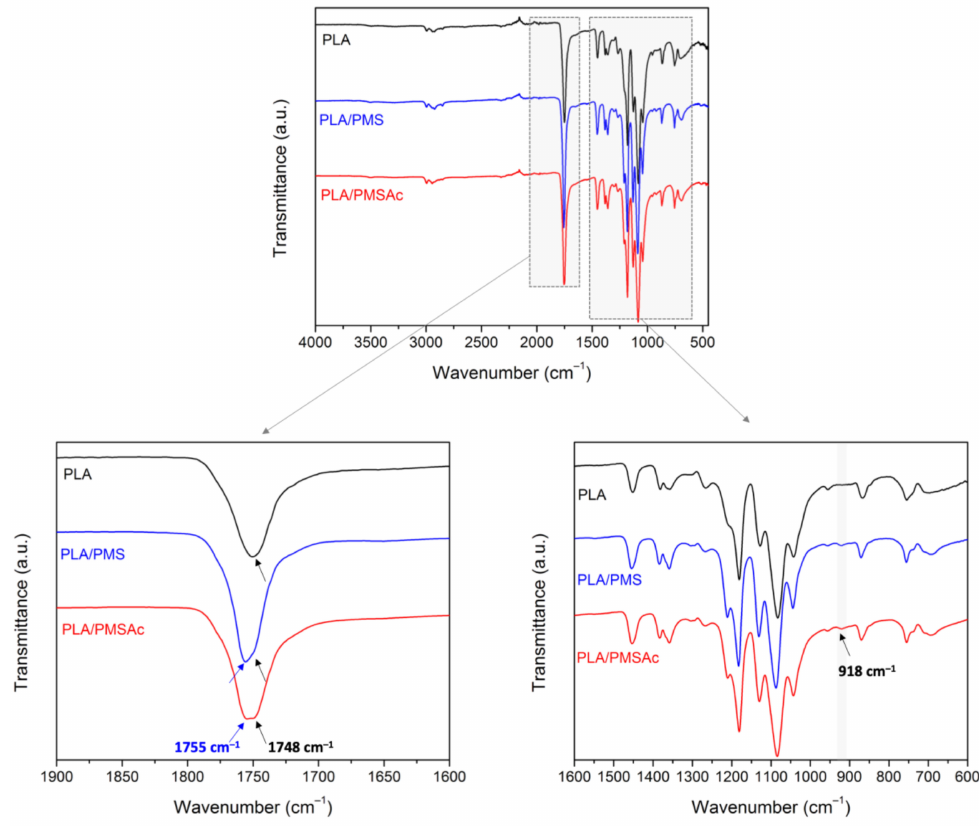
Figure 4. ATR–FTIR spectra of the electrospun fibers in the region of 1800–600 cm − 1